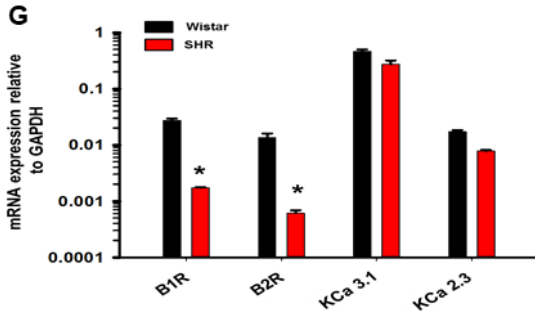
Figure 3. Molecular detection of bradykinin (BK) receptors and KCa channels in Wistar and SHR mesenteric arteries. The protein expression of BK receptor type 1 (B1R, panel ( A )) and type 2 (B2R, panel ( B) ), along with KCa2.3 and KCa3.1 channels (panels ( D) and ( E) ) was analyzed by western blot in mesenteric artery homogenates derived from age-matched SHRs and Wistar rats. Homogenates prepared from human intra-thoracic arteries (ITA) and human umbilical vein endothelial cells (HUVECs) served as positive controls for the detection of B1R and B2R proteins. Lysates prepared from HEK 293 cells transfected with cDNA encoding either KCa3.1 or KCa 2.3 channels were used as positive controls and are displayed in lane 1 of the corresponding blots. HEK 293 cells transfected with cDNA encoding mouse Kir2.1 channel served as a negative control. Quantification of protein expression for B1R and B2R, and KCa2.3 and KCa3.1 channels is shown in panels ( C) and ( F) , respectively. Staining intensities of selected immuno-reactive bands are expressed as a ratio with detected β -actin expression in the same homogenate. The asterisk (*) signifies a statistical difference between the indicated groups ( n = 4–5 animals), as determined by a Student’s t-test, p < 0.05. Panel ( G) quantifies the levels of mRNA encoding B1R, B2R, KCa2.3 channel, and KCa3.1 channel in mesenteric arteries from SHRs and Wistar rats, as determined by real-time, quantitative PCR analyses. The ratio of mRNA expression for each target in the Wistar and SHR mesenteric arteries was calculated using REST software [34]. Detection of GAPDH mRNA was utilized as an internal reference in all assays. Data are expressed as means ± S.D. and statistical analyses were determined by one-way ANOVA and a Tukey’s post-hoc test ( n = 4–5 animals per